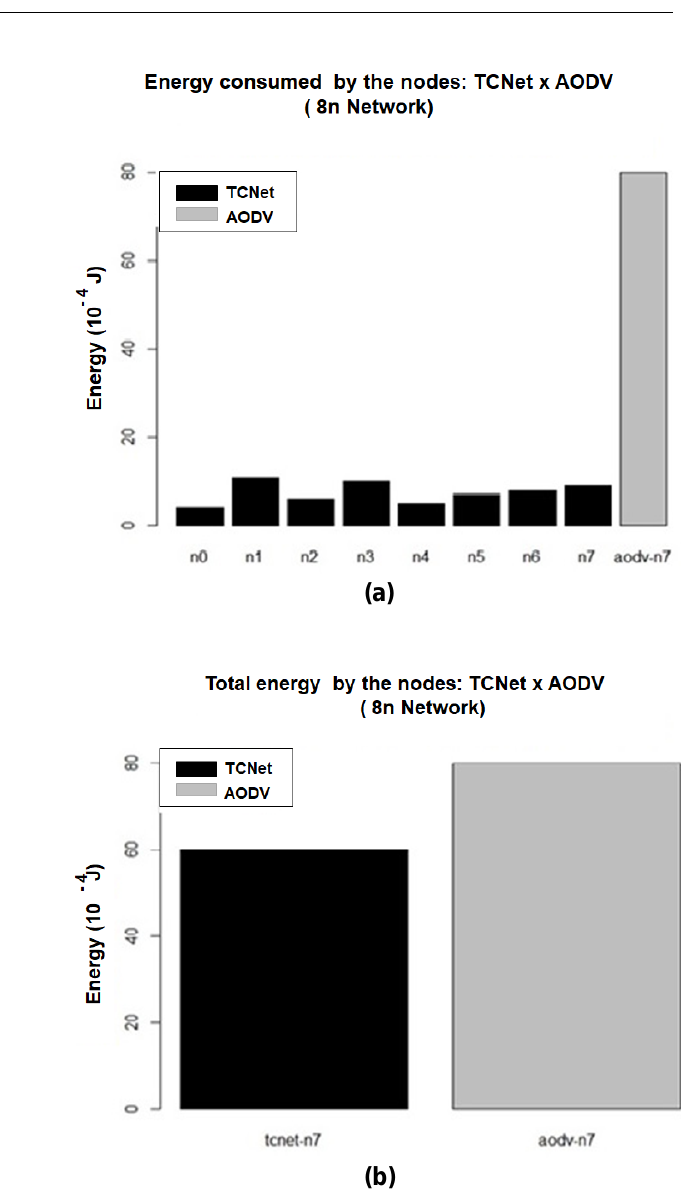
Figure 9 . (a) Energy distributed among TCNet nodes in relation to the energy consumed by the AODV; (b) Comparison between the total energy consumed by the mechanisms of TCNet x